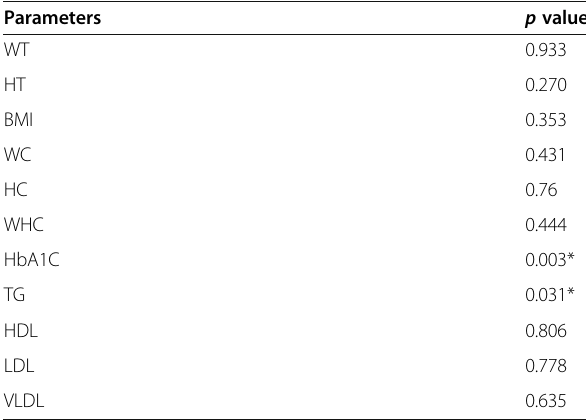
Table 3 P values of biochemical and anthropometric parameters regarding